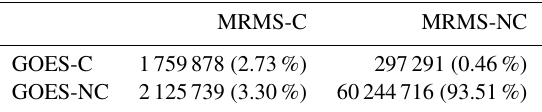
Figure 8. Convective regions detected by GOES-16 (in Fig. 7c) are colored in navy on top of MRMS PrecipFlag at 22:30UTC on 18 June 2018 (Fig. 7a). Pink represents convective while green rep- resents stratiform). Table 3. Contingency table of results applying both of GOES de- tection methods and validating against MRMS data during June of 2017. Pixel-based validation is conducted to produce this table. C and NC represent convective and non-convective, re- spectively. GOES-C/MRMS-C denotes “hits” that both MRMS and GOES methods detected as convective within 5km. GOES- NC/MRMS-C denotes “misses” that GOES missed detecting con- vection while MRMS assigned as convective. GOES-C/MRMS-NC denotes “false alarm” that GOES detected as convective, but MRMS did not. GOES-NC/MRMS-NC denotes a “correct negative case” that neither MRMS nor GOES detected as convective. Percentages in the parenthesis are obtained by dividing each number by the total number.